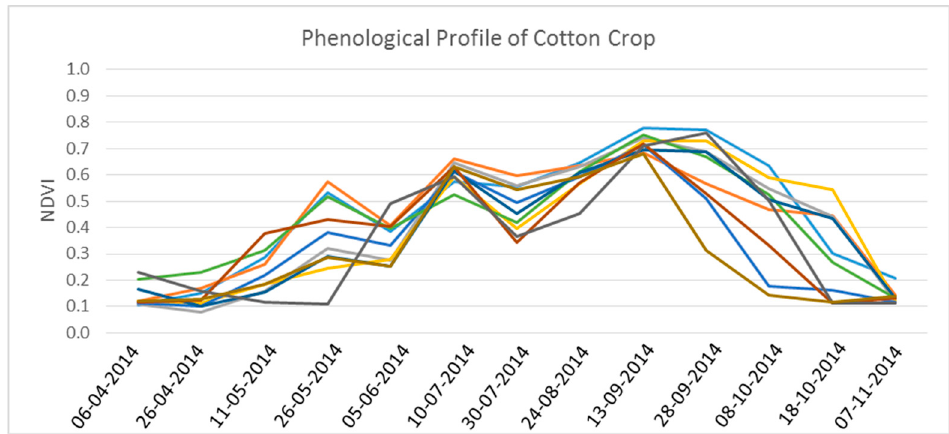
Figure 6. Phonological profile of cotton crop.